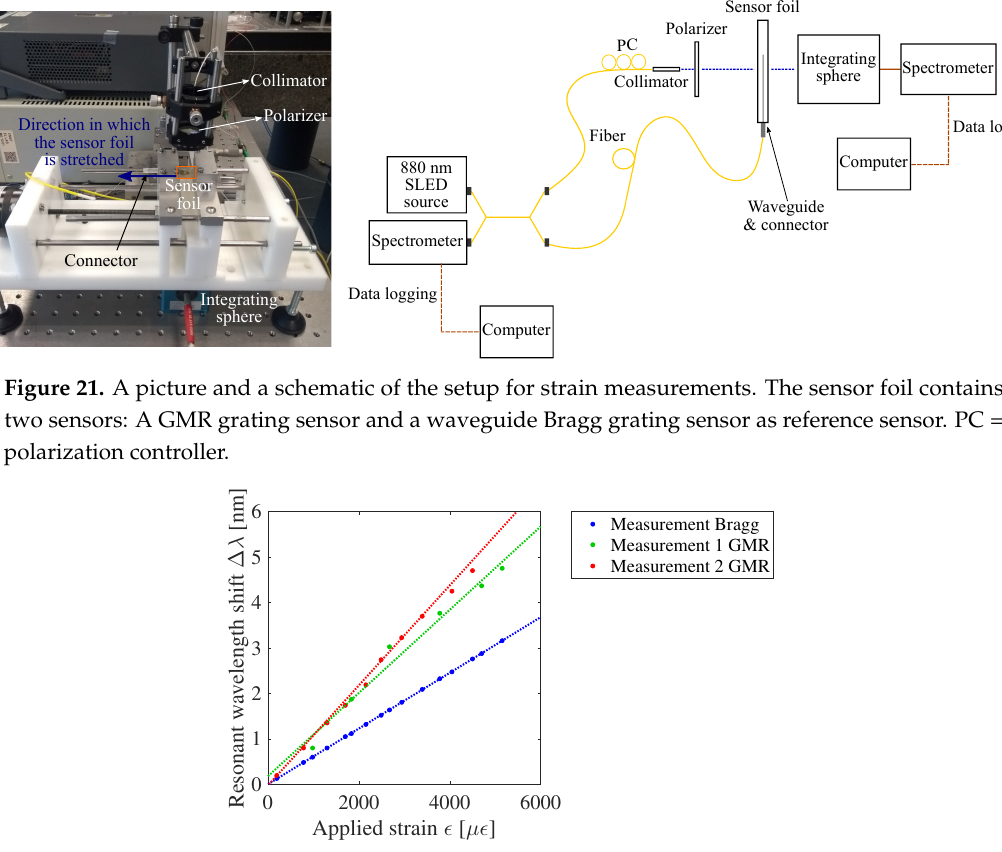
Figure 22. The measured resonant wavelength shift ∆ λ as a function of the applied strain (cid:101) for the waveguide Bragg grating and the GMR grating in